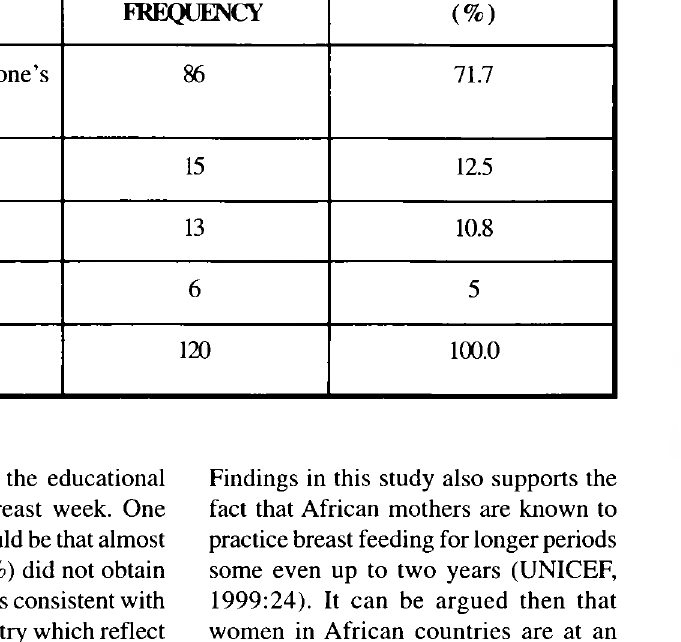
Table 2: Responses/Frequency on Causes of Breast Cancer (N = 120)